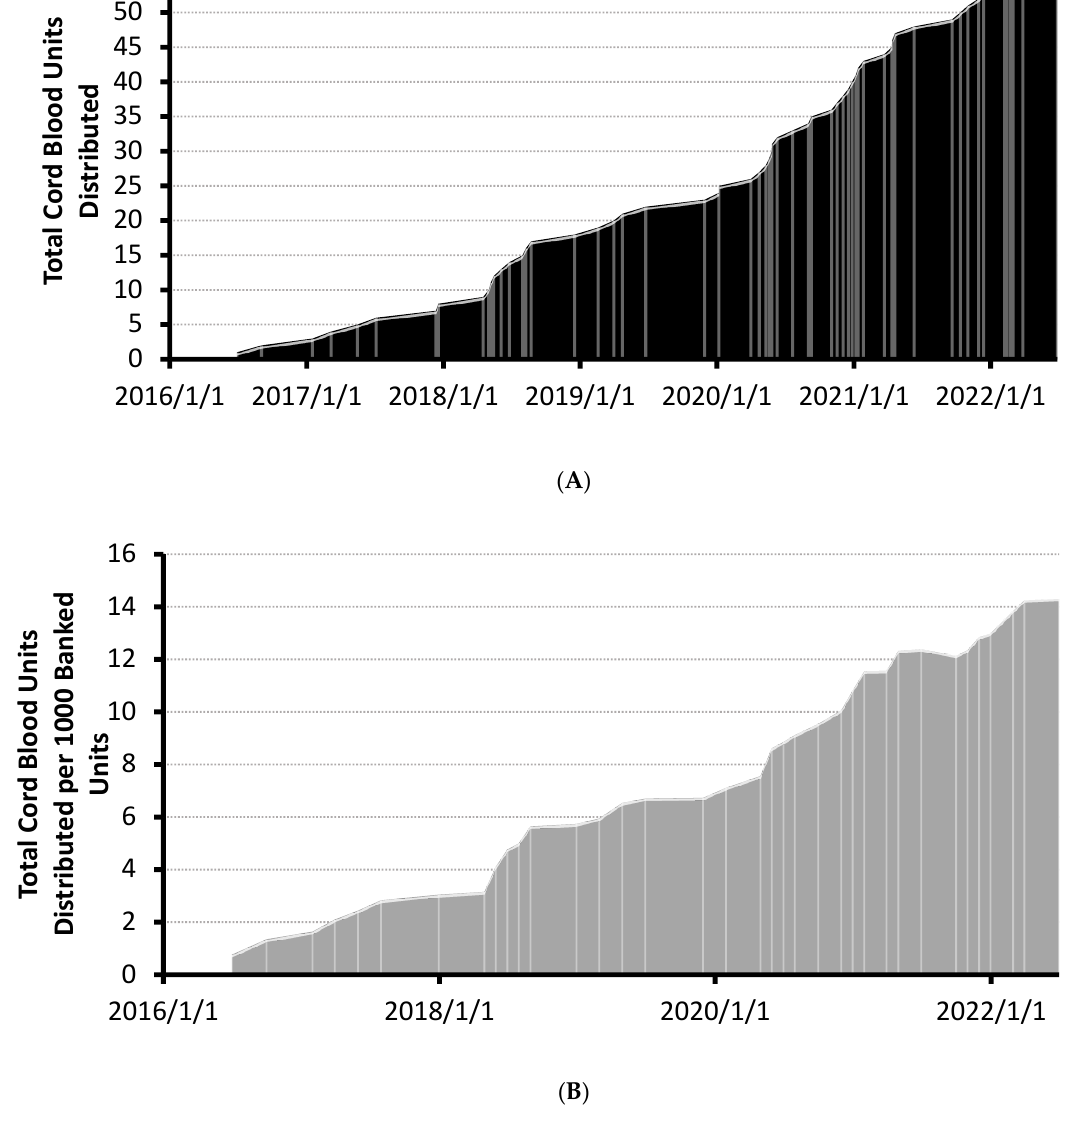
Figure 1. ( A ) Cumulative plot of cord blood units distributed over time. Shipment dates of cord blood units are demarcated with lightly colored lines. Cord blood bank accreditation dates are indicated on the plot. ( B ) Cumulative plot of cord blood units distributed per 1000 banked CBUs over time. Total CBUs distributed were normalized to end-of-month total inventory counts of banked CBUs. Updated total of distributed units per thousand banked CBUs are demarcated with lightly colored lines. Cord blood bank accreditation dates are indicated on the plot. AABB accreditation (2016-01-01) and FACT accreditation (2019-02-25) received. Table 1. Usage of the CBS’ Cord Blood Bank.